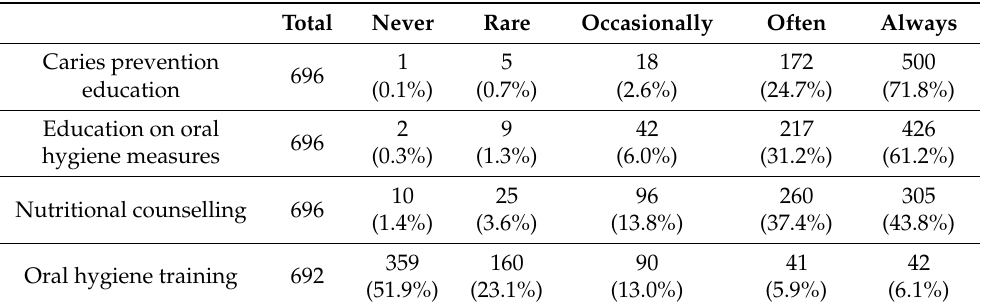
Table 5. Measures carried out in children between 6 and 33 months as part of caries prevention in absolute values and in percent (%).